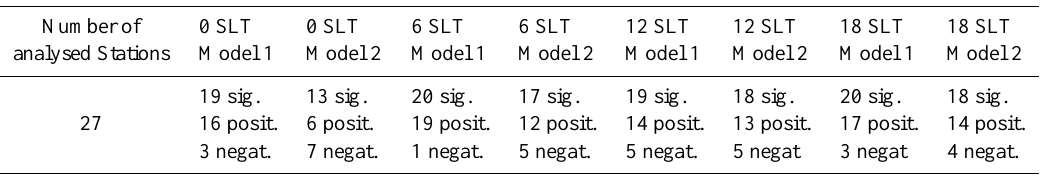
Table 3. Number of stations with significant (positive and negative) hm F2 trends taking into account the results presented in Table 2. Confidence level of 95% is applied